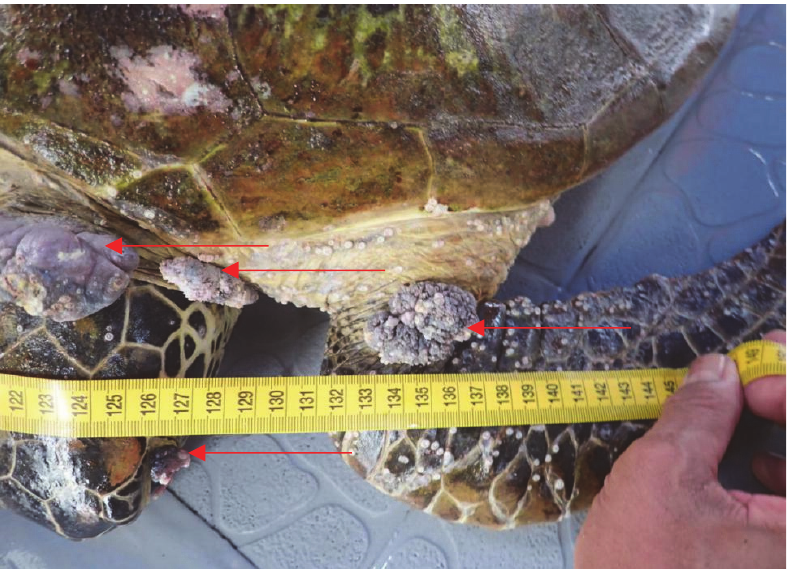
Figure 1. A juvenile green sea turtle with multiple FP tumors (arrows) on its flippers, neck, and eyes, that was caught on Mabul Island during the sampling period in November 2019.